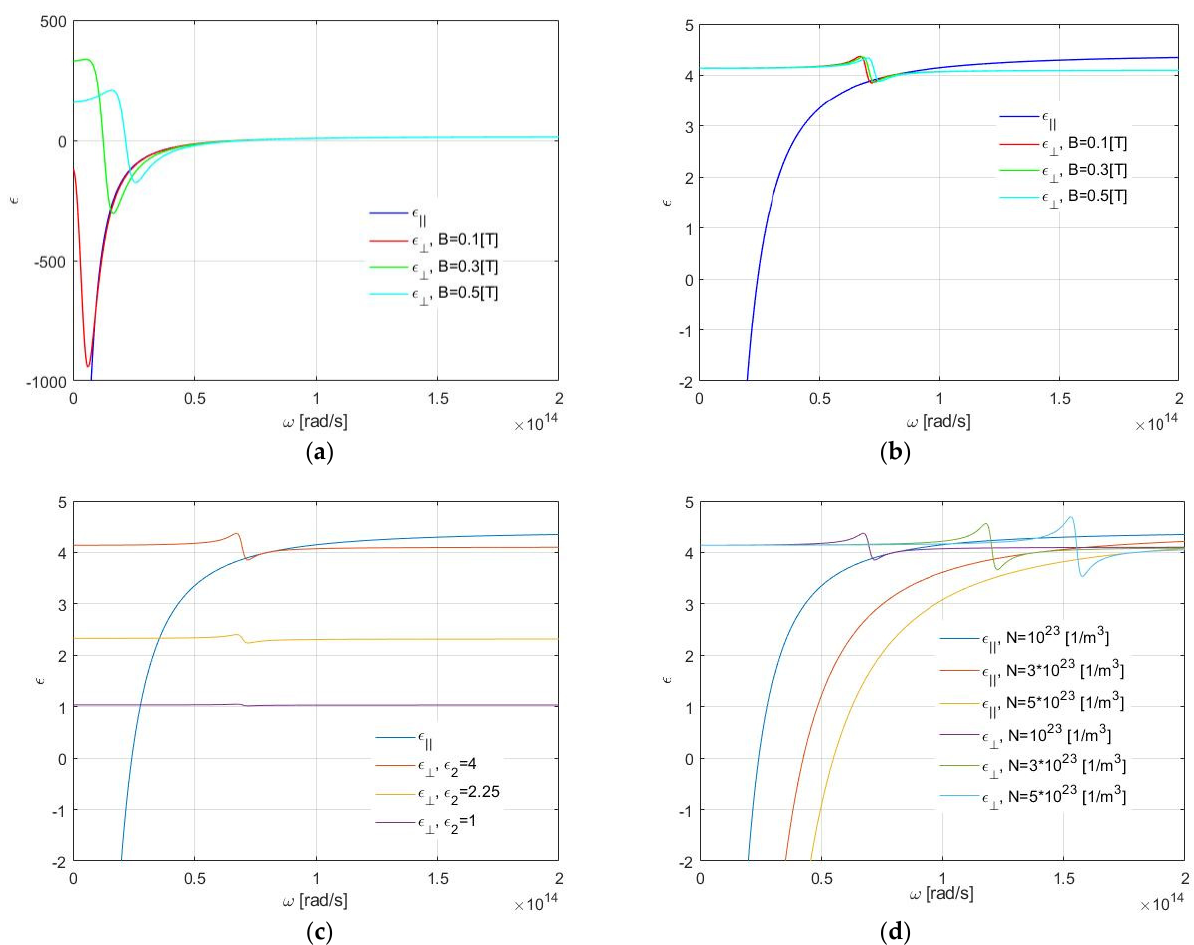
Figure 2. Dependencies of the optical properties of anisotropic semiconductor ( a ) and semiconductor-based nanostructured metamaterial ( b – d ) versus frequency.